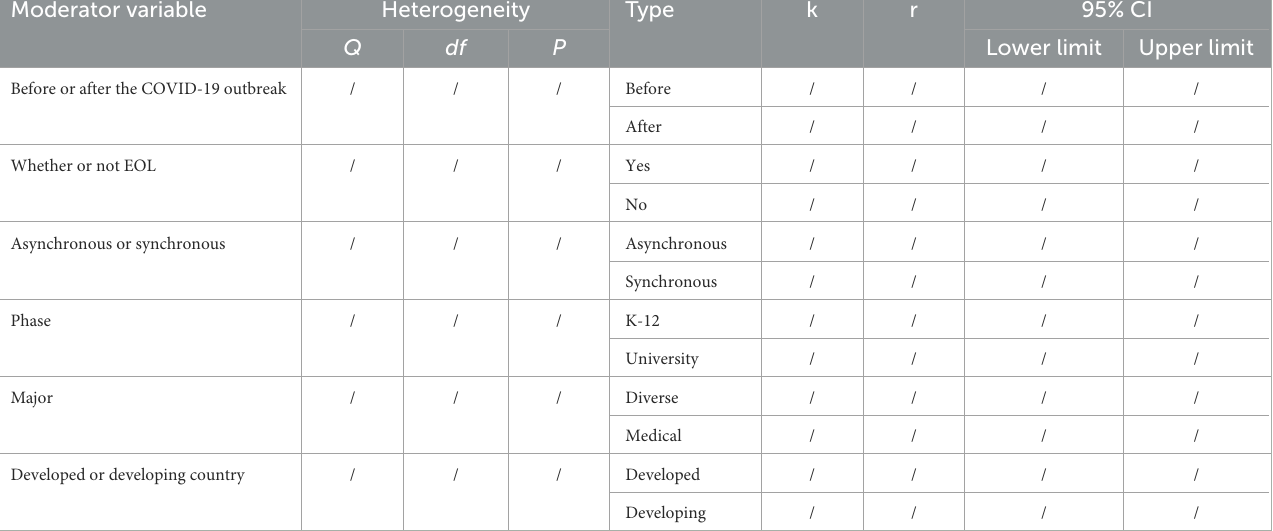
TABLE 8 Moderator analysis for parent